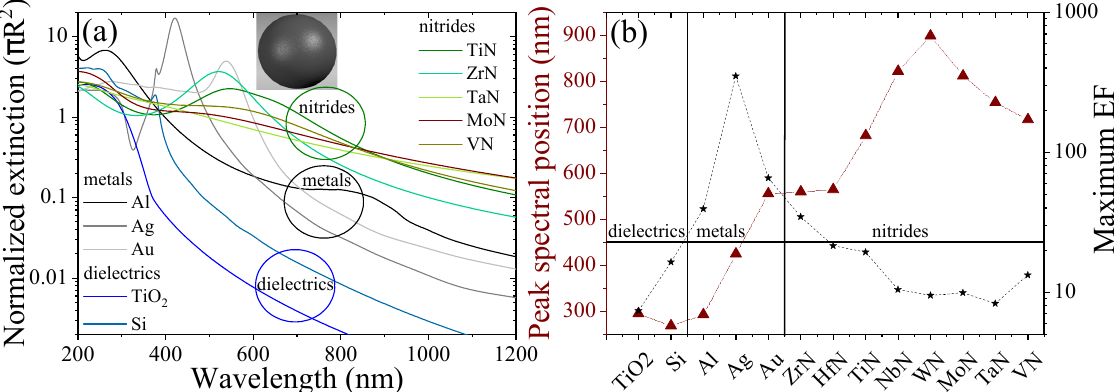
Figure 2. Potential enhancement of absorption and local fields of various material classes. For spherical nanoparticles of radius R = 25 nm of the depicted materials placed in a SiN x host matrix the ( a ) normalized extinction and ( b ) maximum field enhancement factor (EF) and its the spectral position are given. The vertical lines separate the different material classes. The horizontal line lies at EF = 30.